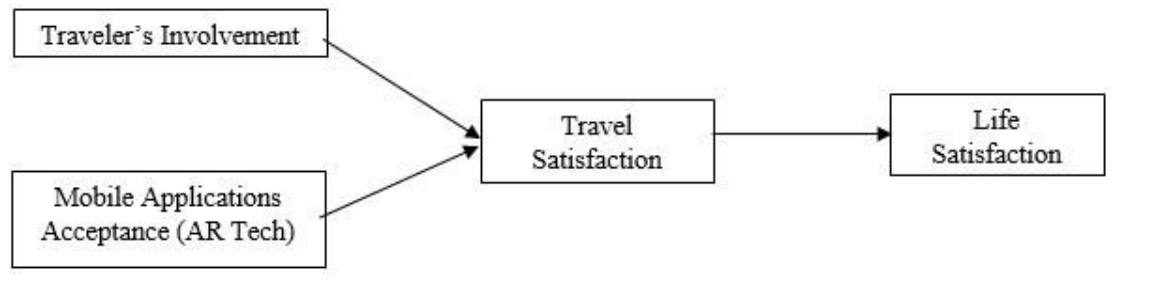
Figure 1. Conceptual framework.